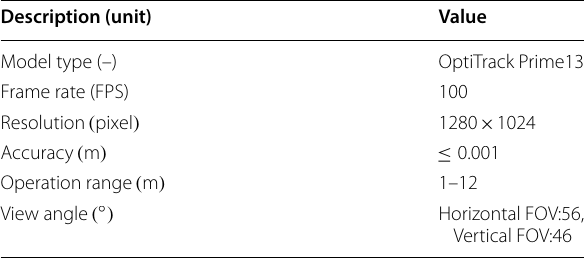
Table 4 Specification of motion capture system